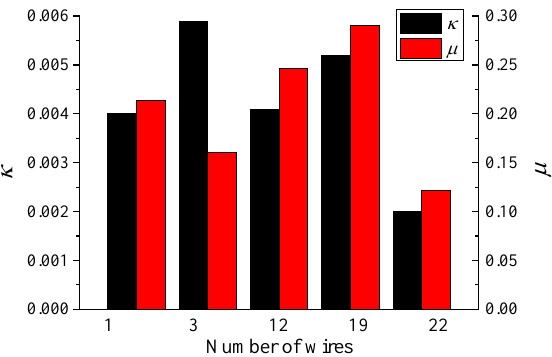
Figure 17. Suggested values based on project of Malinghe Bridge.